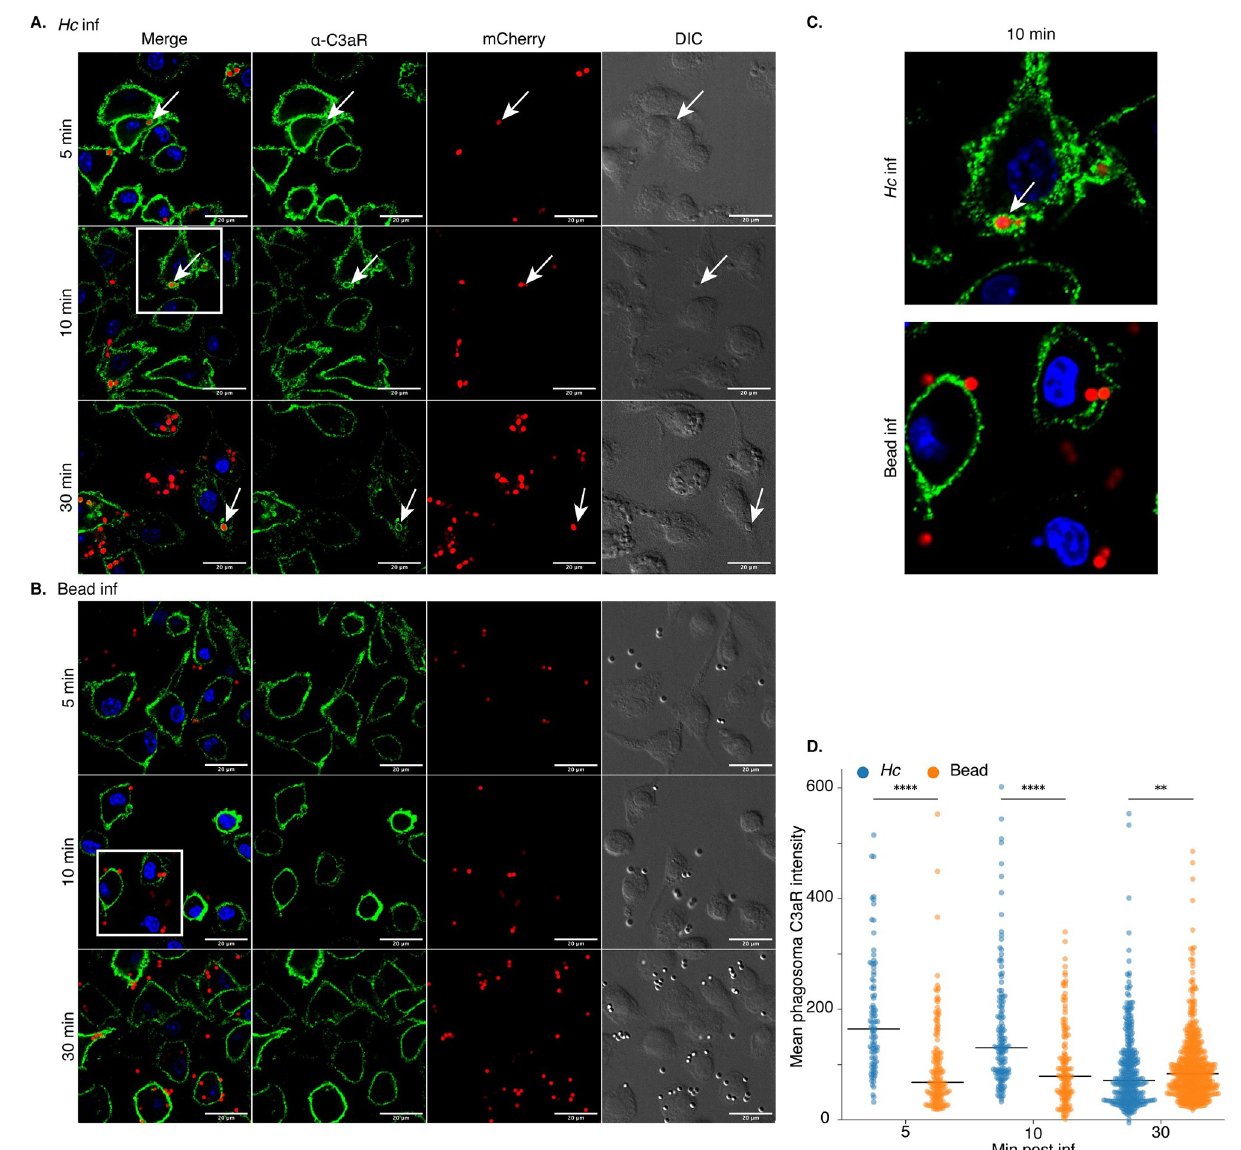
Fig 5. C3aR localizes to the early Hc -containing phagosome. C3aR localizes to Hc -containing phagosomes (A) to a greater extent than latex bead- containing phagosomes (B). BMDMs were infected with the indicated particles (MOI = 5, n = 2 biological replicates per time point). Cells were then stained with a C3aR-specific antibody and imaged using optical sectioning with a confocal microscope. Representative images from a single slice are shown. C. Enlarged views of insets outlined in panels A and B by a white box. Scale bar = 20 μ m. D. The mean fluorescence intensity of C3aR in the particle-containing phagosomes was quantified using ImageJ (N > 91 phagosomes, ���� p < 0.0001, �� p < 0.01 by two-tailed Wilcoxon rank-sum test). The line represents the median phagosomal C3aR